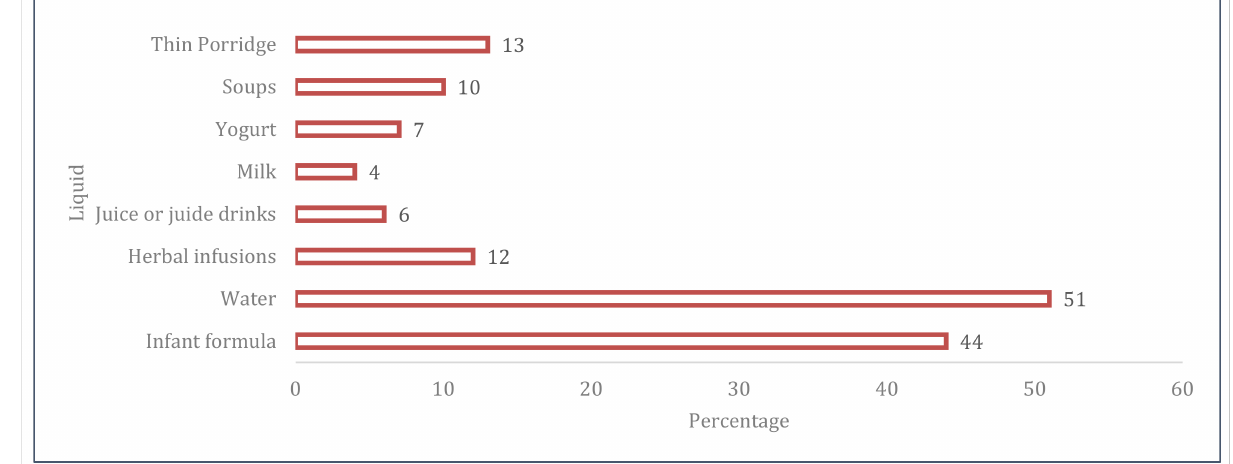
Figure 2. Liquids consumption among infants (0–6 months).